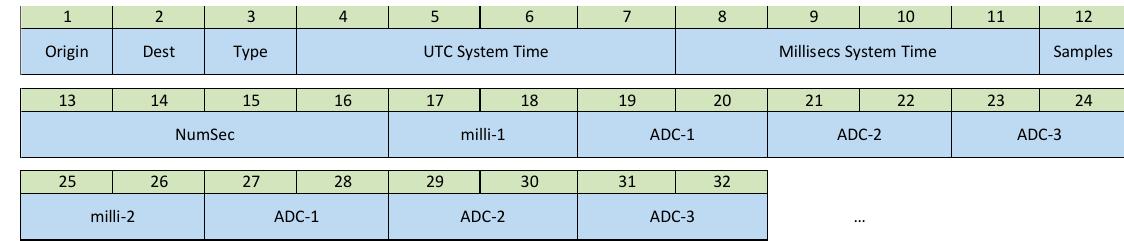
Figure 4. Structure of the Sampling Order message.